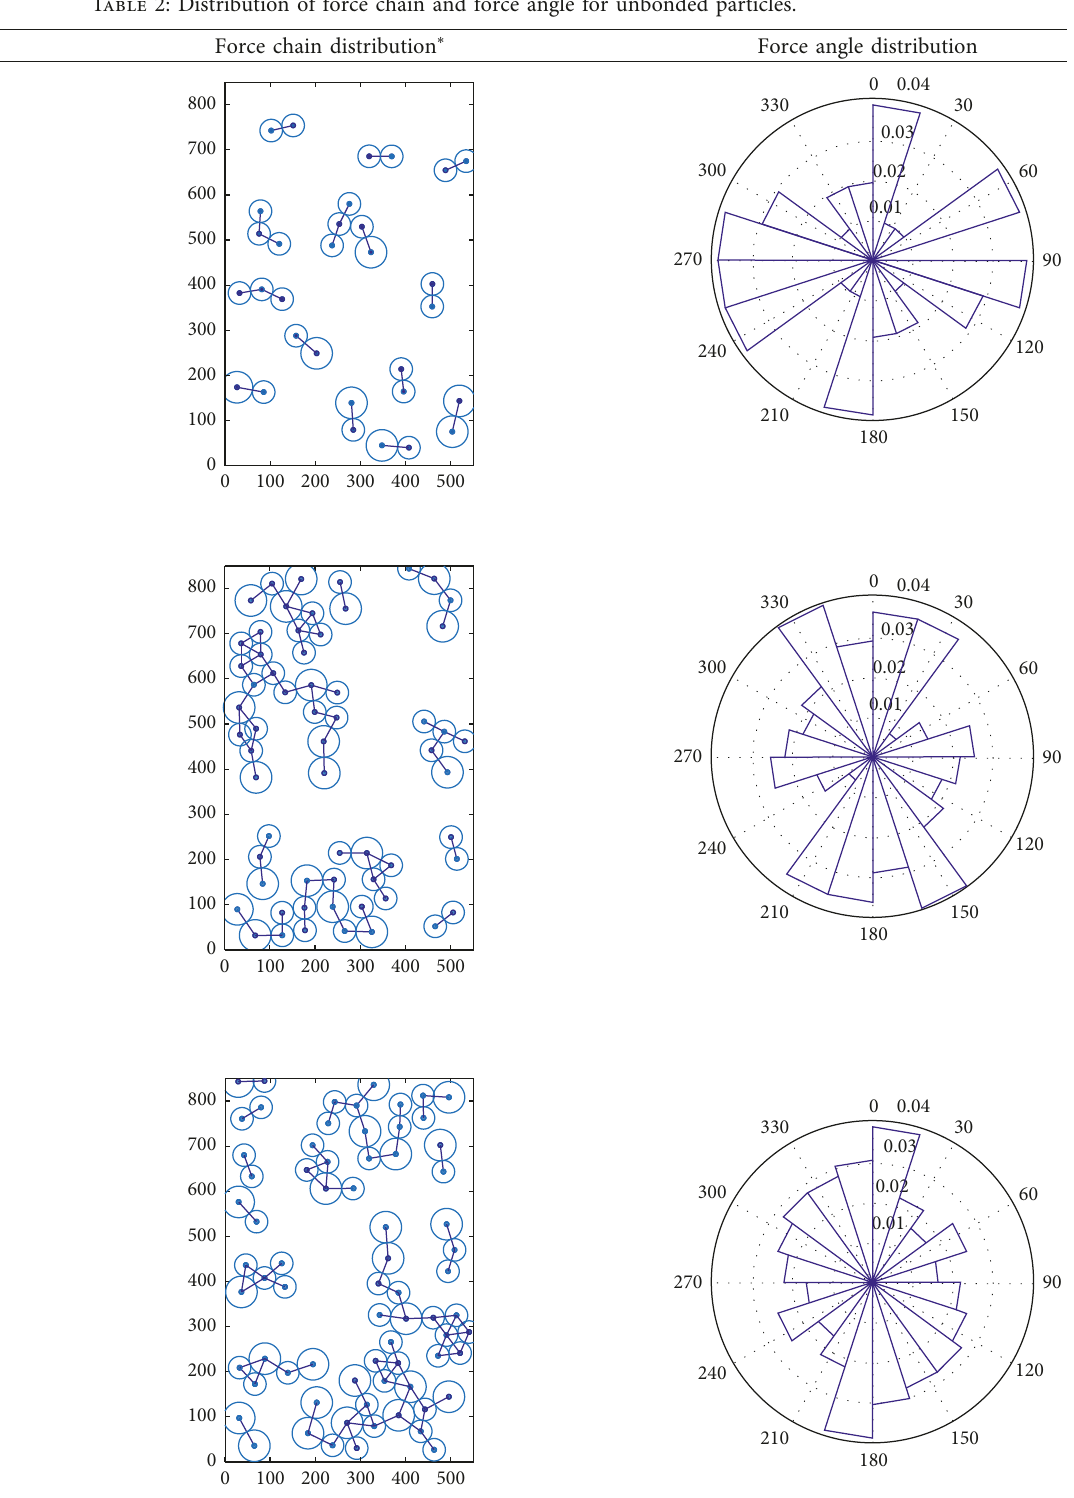
Table 2: Distribution of force chain and force angle for unbonded